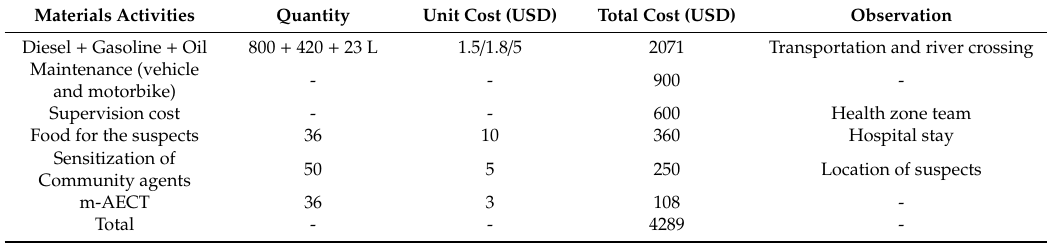
Table 2. Marginal direct cost of active search strategy from January 2017 to April